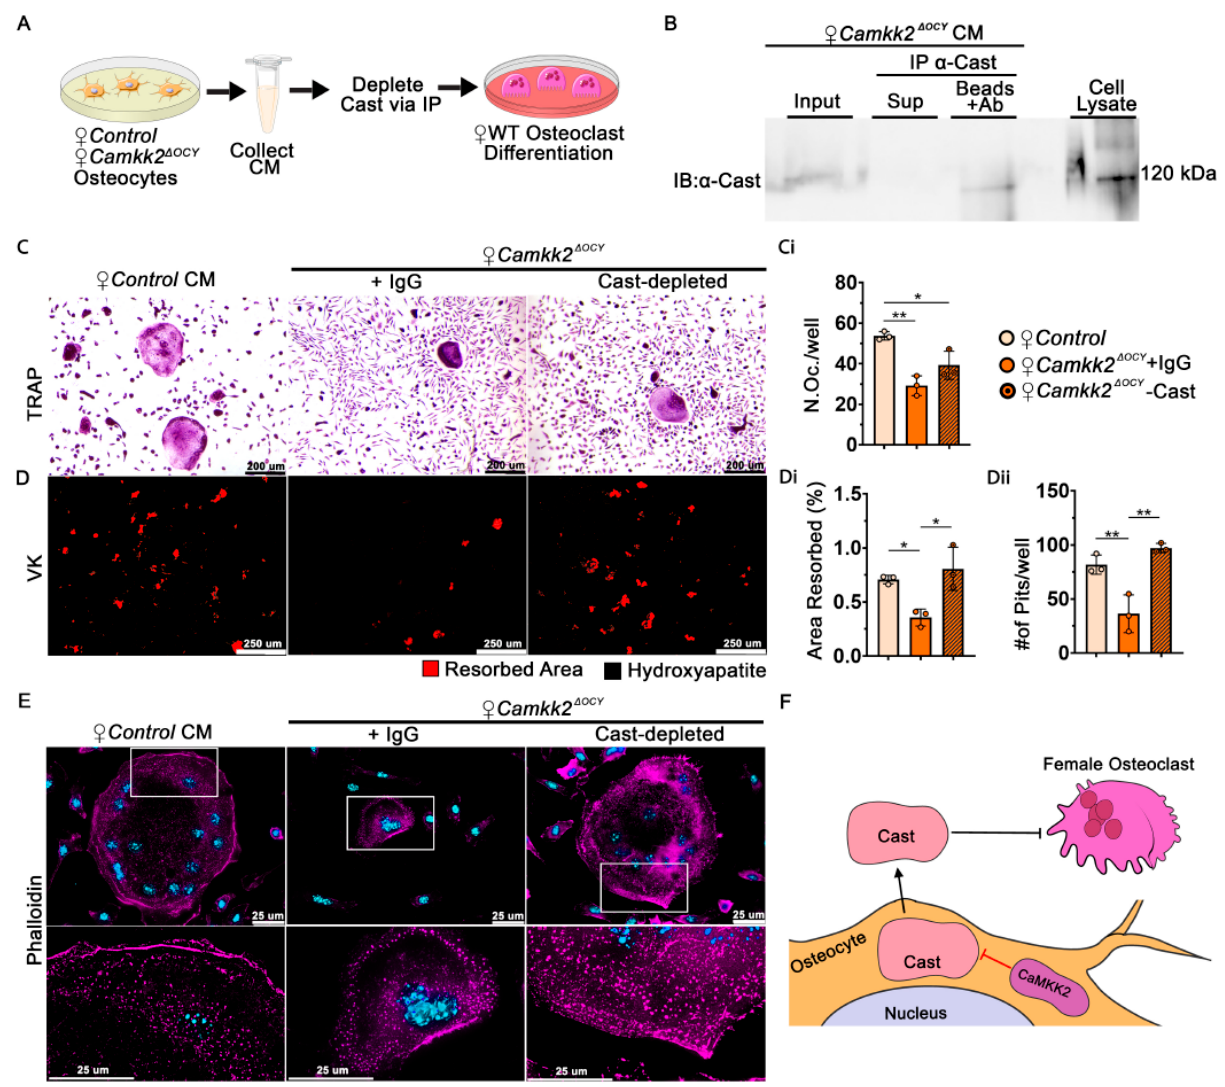
Figure 5. Depletion of Calpastatin from conditioned media of female CaMKK2-deficient osteocytes restores osteoclast function. ( A ) Schematic of experimental design outlining the collection of female osteocyte CM and depletion of Cast by immunoprecipitation (IP) with α -Cast antibody or control IgG prior to treating WT BM cells during OC differentiation. ( B ) Immunoblot of Cast levels in female Camkk2 Δ OCY osteocyte CM (input) prior to IP as well as supernatant and substrate (Cast) captured by antibody conjugated beads post-IP. ( C , D ) Representative images ( n = 3/group) magnification 100×) showing TRAP-positive OCs and hydroxyapatite resorption by WT OCs treated with female control osteocyte CM or Camkk2 Δ OCY osteocyte CM depleted of Cast or treated with control IgG. ( Ci ) Number of TRAP positive OCs (purple) with 3 or more nuclei, ( Di ) percent hydroxyapatite area resorbed (red), and ( Dii ) number of individual pits measured using ImageJ ( n = 3/group). ( E ) Representative images (magnification 630×) of phalloidin staining OCs from indicated treatment conditions to vis- ualize the filamentous ( F ) actin cytoskeleton (pseudo-colored magenta) and DAPI stain to visualize nuclei (blue). Magnification (200%) of outlined regions of interest using Leica LASX software is shown underneath each image. ( F ) Proposed mechanism indicating that during homeostasis, CaMKK2 negatively regulates osteocyte Cast levels. Osteocyte-derived extracellular Cast inhibits the function of female OCs. Error bars represent SD. * p < 0.05, ** p < 0.01. 3. Discussion The objective of the current study was to investigate a cell-intrinsic role of CaMKK2 in osteocytes, the master regulators of skeletal homeostasis [6]. Conditional deletion of